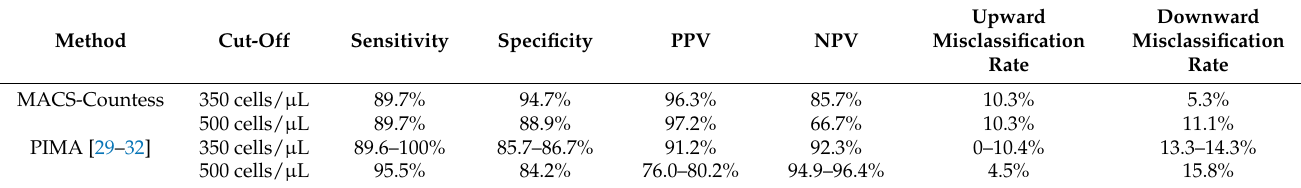
Table 2. Sensitivity, specificity, PPV, NPV, and misclassification rates of MACS-Countess to the reference FASC at cut-off 350 and 500 cells/ µ